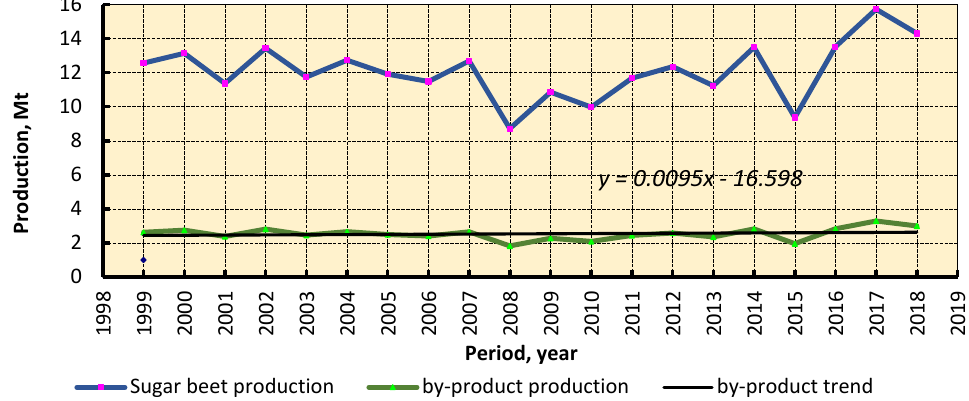
Figure 6. Sugar beet and its leaf yield and production history.